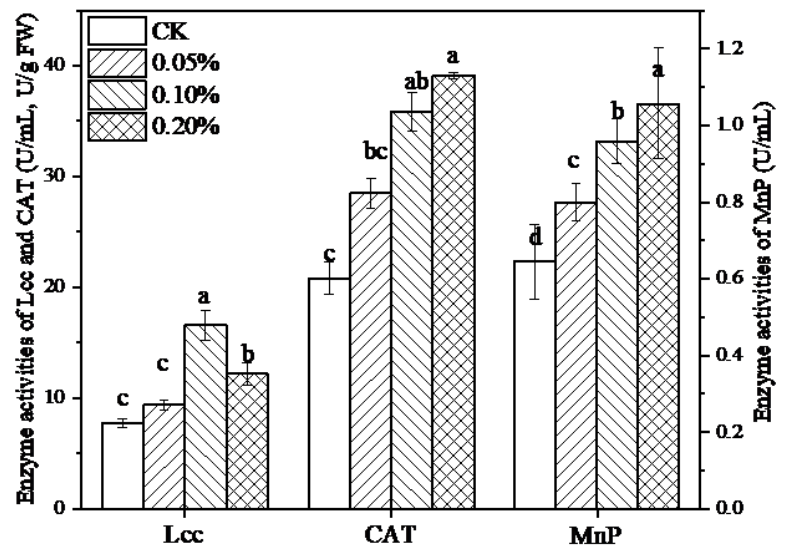
Figure 4. Enzyme activities of Lcc, CAT, and MnP in the absence or presence of lignin. Results are presented as means ± SD of three replicates. Different letters represented the significant differences among sample groups ( p < 0.05). Statistical analysis was carried out by one-way ANOVA accompanied by Duncan’s test using SPSS (version 20.0).